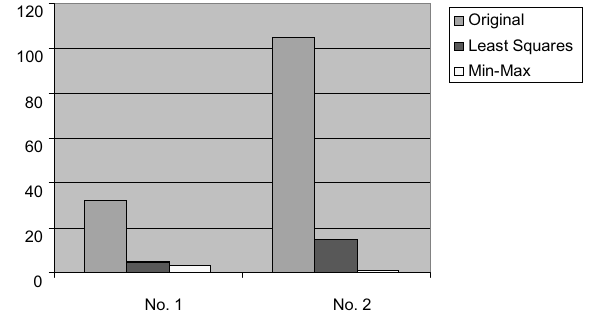
Fig. 5. Amplitude comparision for the gas turbine: least squares vs